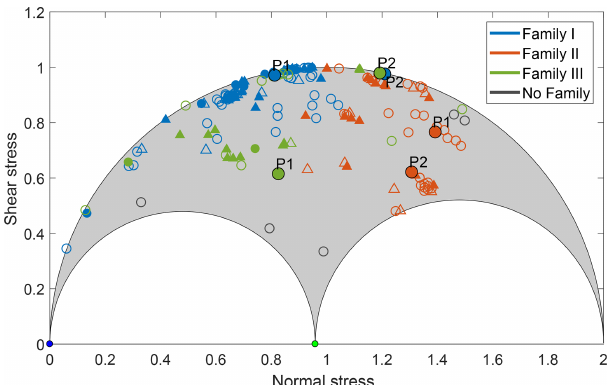
Figure 10. Deviatoric Mohr circle representing the local stress field, with the fault plane solutions having the highest fault instability co- efficient of the estimated focal mechanisms. The stress inversion re- sulted in a stress ratio of R = 0 . 53. Events with M w ≥ 1 and M w < 1 are plotted as triangles and circles, respectively. Filled and unfilled markers represent events with manually picked and estimated po- larities, respectively. The mean and its auxiliary fault plane solution of each family are plotted as filled large dots labeled as P 1 and P 2, respectively. Most family I events (blue symbols) occurred on critically stressed faults.